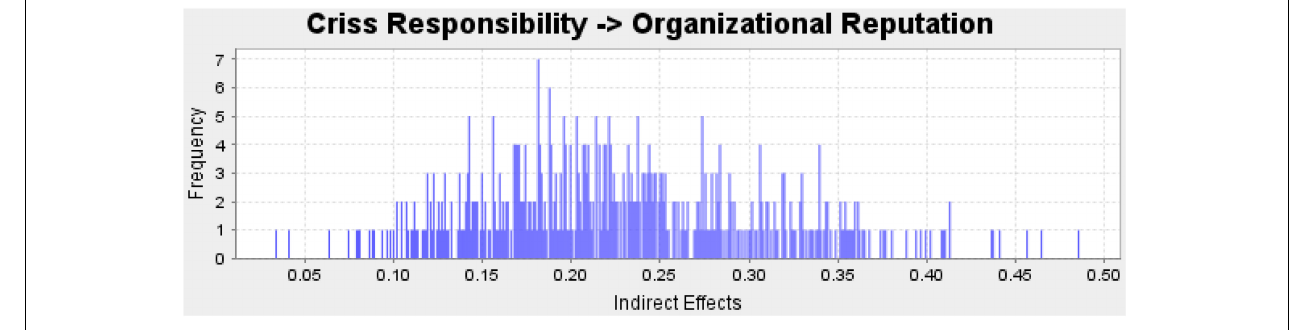
FIGURE 3 | Indirect effect histogram.